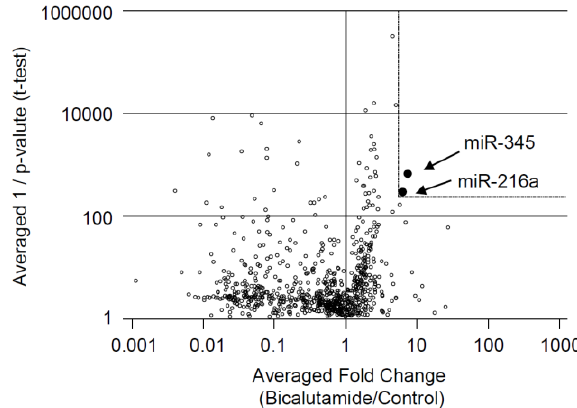
Figure 2. Volcano plot shows comparative analysis of miRNA microarray of the averaged three groups of the bicalutamide-treated cells and vehicle-treated cells. Volcano plot of microarray data generated by clustering based on probes that were retained (fold change >5; p < 0.01) in the averaged three groups of the bicalutamide-treated cells compared to vehicle-treated cells (Control). Closed circles represent selected miRNAs in this